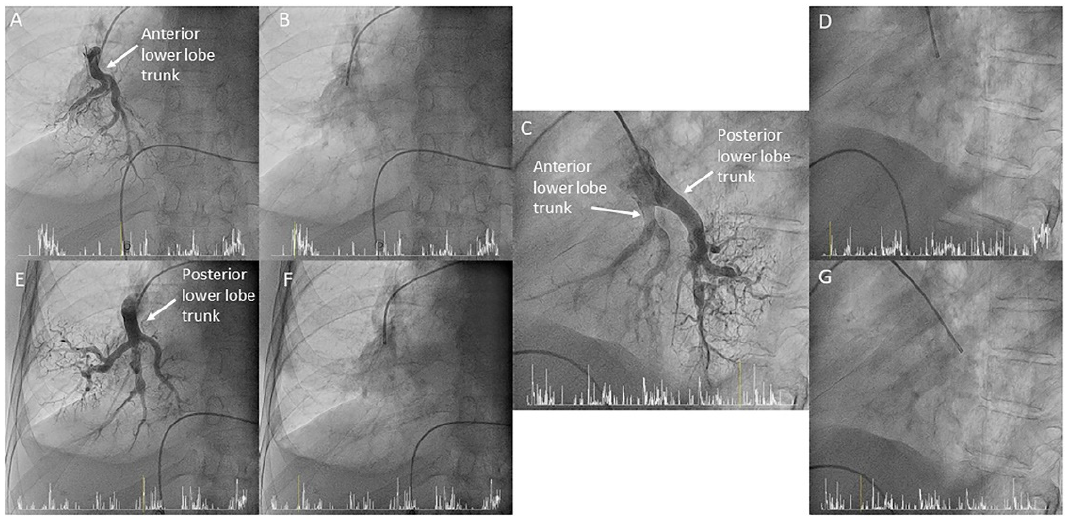
Figure 32. MP catheter canulating the right lower lobe trunks, ( A , C , E ) with and ( B , D , F , G ) without contrast. ( A , B , E , F ) Anteroposterior and ( C , D , G ) lateral views.